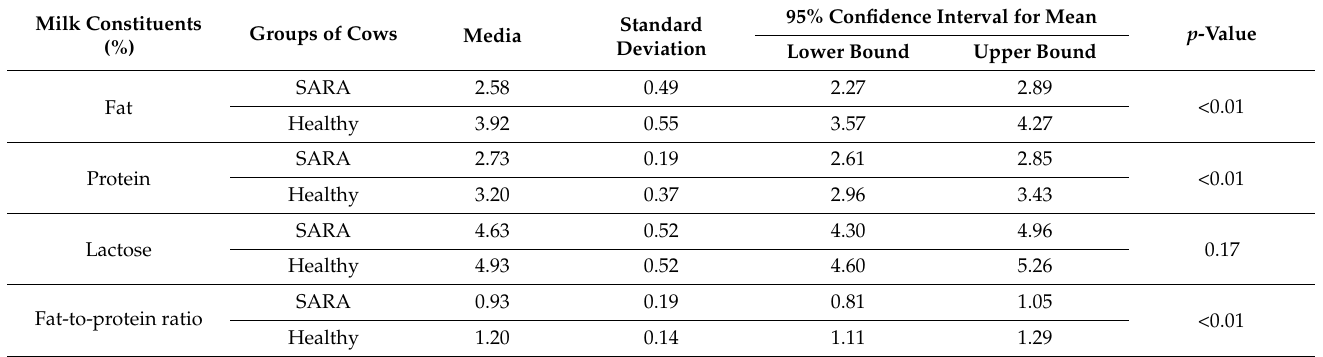
Table 1. Results of ANOVA comparing least square mean of milk constituents between SARA and healthy